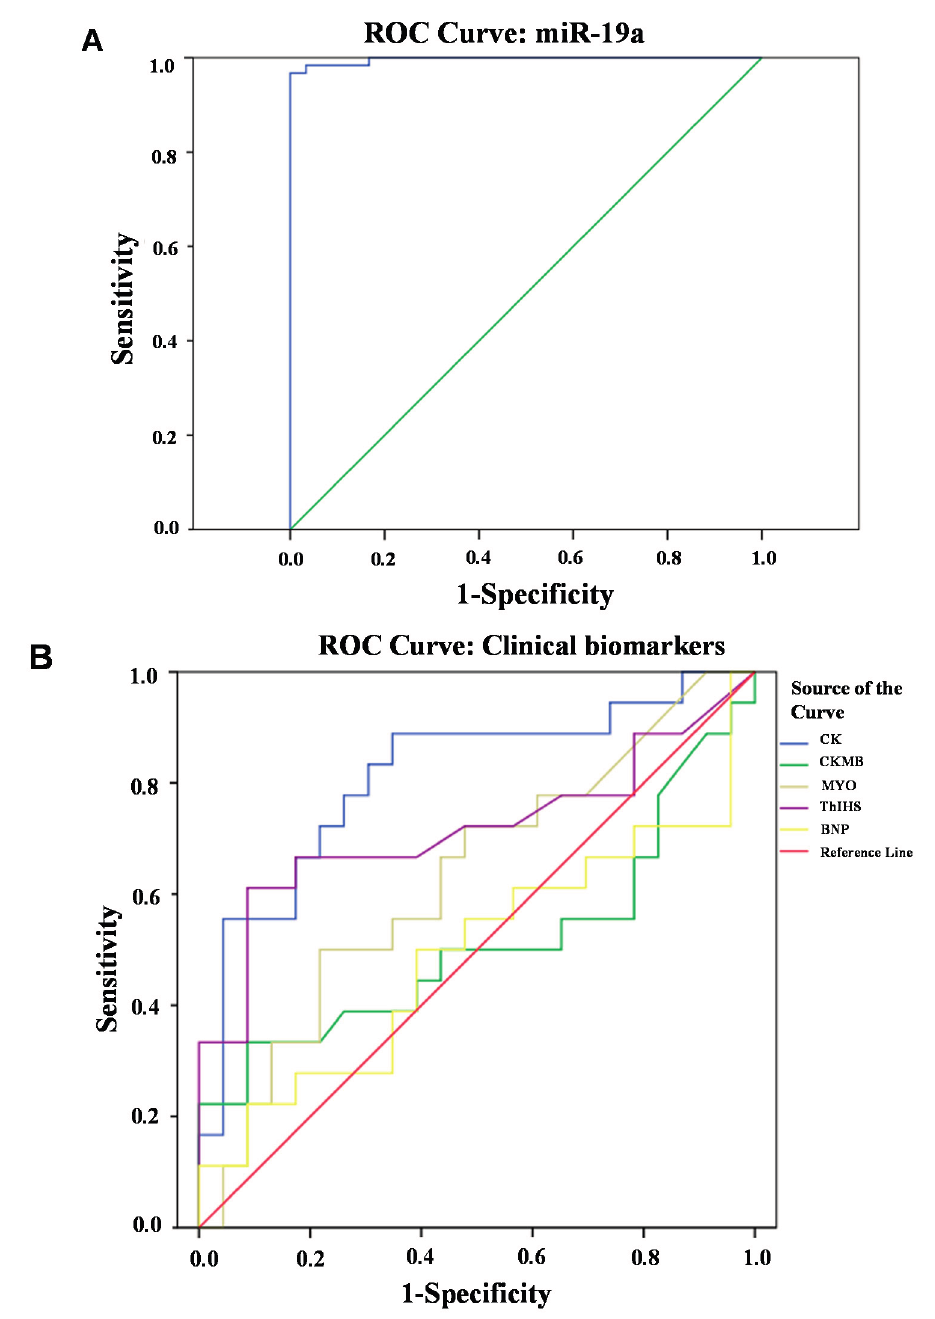
Figure 3. ROC curve analyses of miR-19a and the known biomarkers. ( A ) ROC curve for miR-19a; ( B ) ROC curve for the known biomarkers including CK, CK-MB, MYO, hs-TnI and